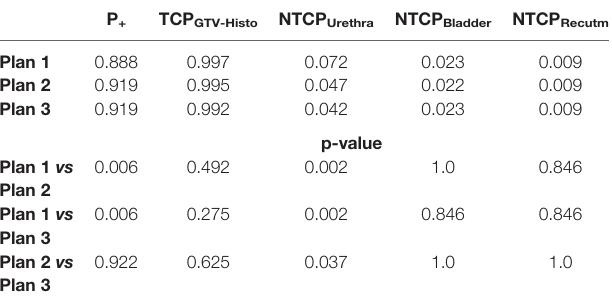
The Lyman-Kutcher-Burman model with an a / b of 5 Gy was applied for urethra.